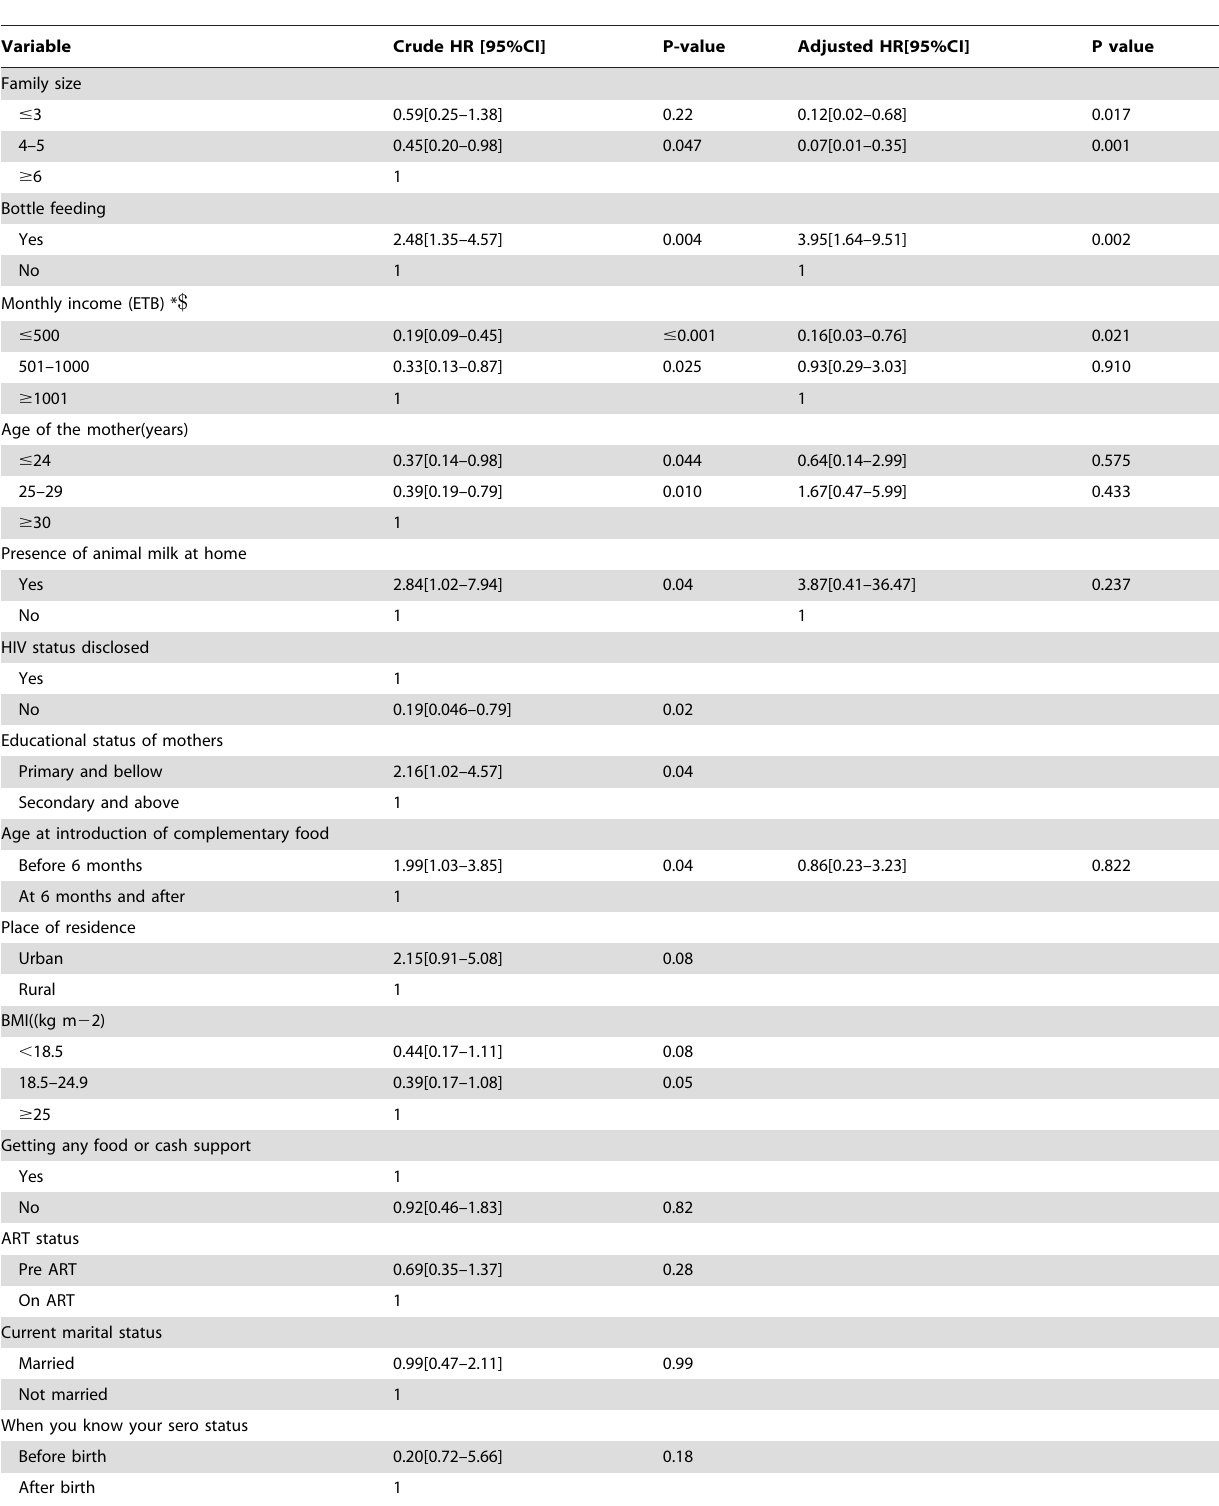
Table 2. Univariate and multivariable analysis of the predictors of breastfeeding cessation among HIV positive mothers in Sidama Zone, Southern Ethiopia,